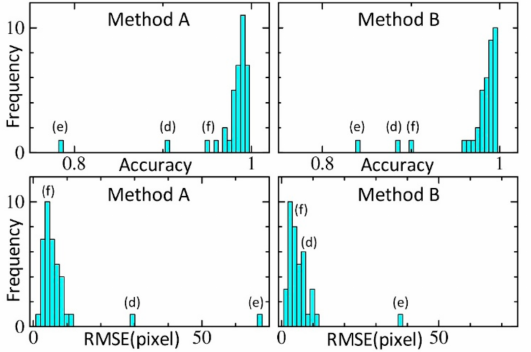
Figure 11. Histogram of the accuracy of land–sea classification ( top ) and RMSE of the extracted shoreline position ( bottom ) for Method A ( left ) and Method B ( right ). In the figure, (d), (e) and (f) indicate the accuracy and RMSE of images (d), (e) and (f) shown in Figure